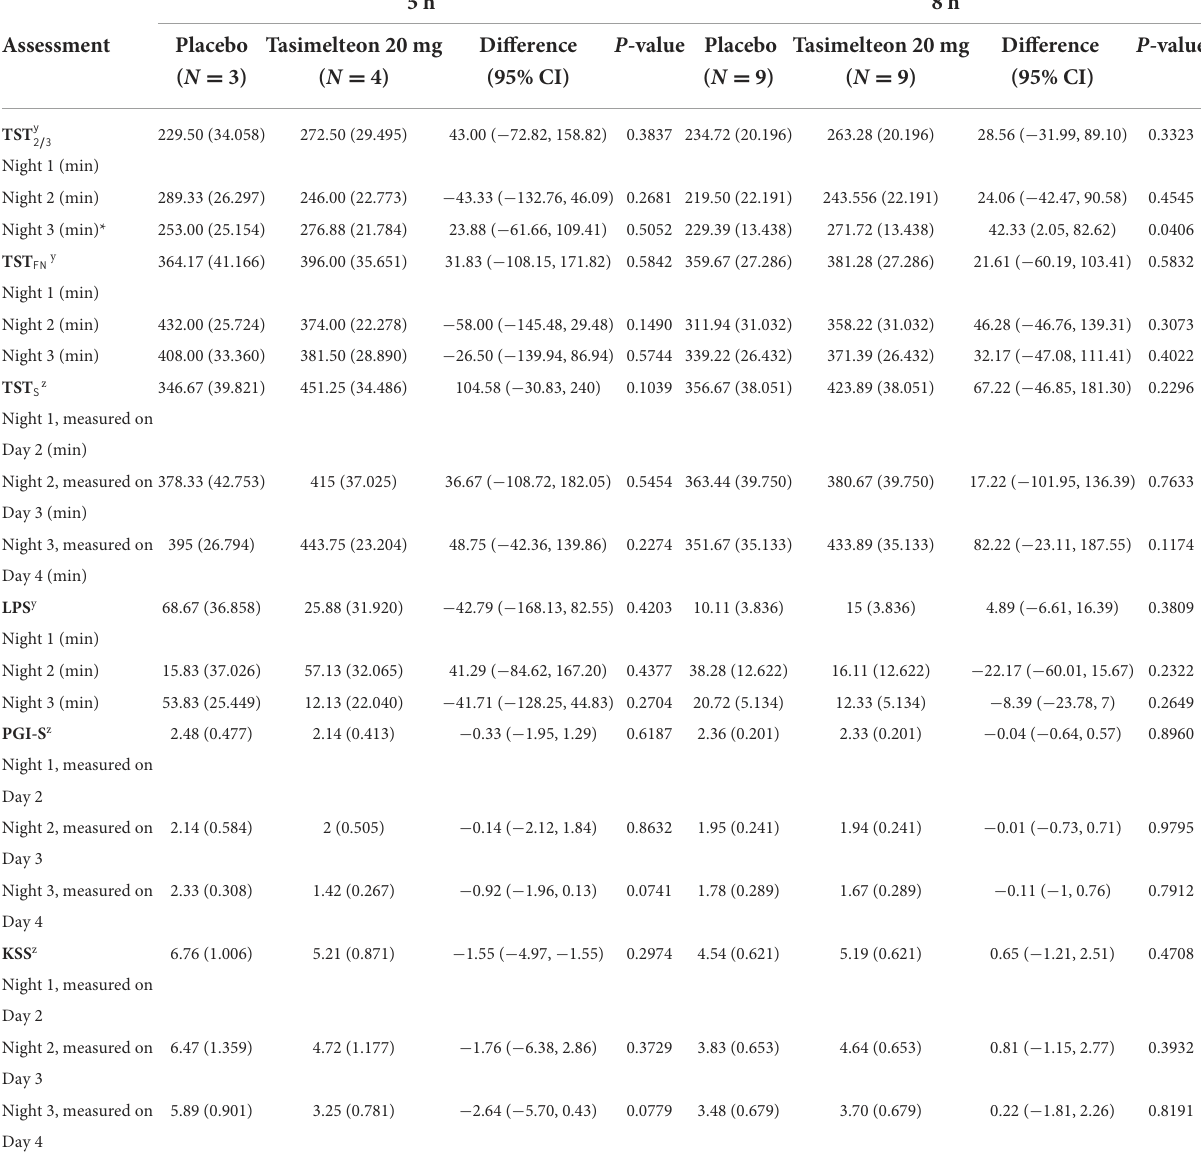
TABLE 3 Summary of endpoints for the ITT population (5 vs.